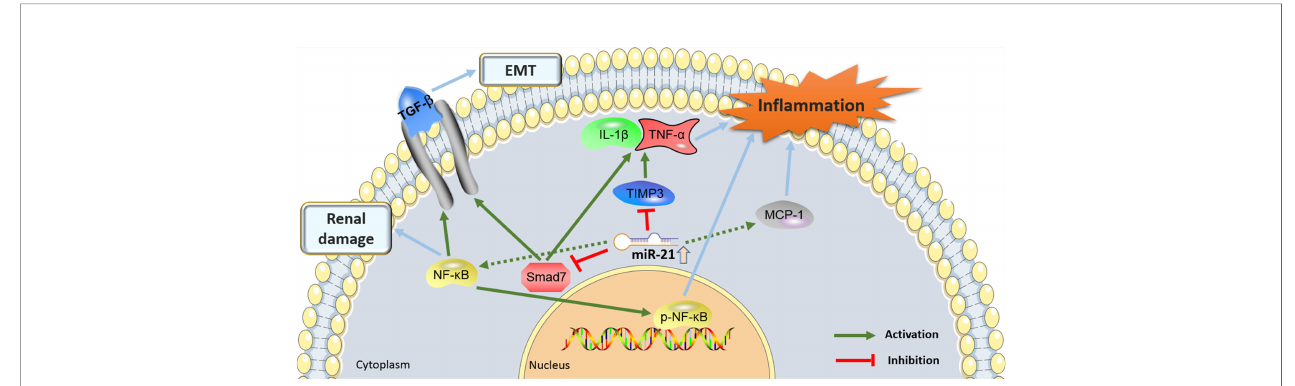
Figure 3. The proin fl ammatory molecular mechanisms by which the miR-21 and its target genes contributes to the pathogenesis of diabetic nephropathy (DN). miR- 21, MicroRNA-21; TGF- b , Transforming growth factor- b ; TIMP3, tissue inhibitors of metalloproteinase 3; EMT, epithelial-to-mesenchymal transition; NF-Kb, nuclear factor k B; MCP-1, monocyte chemoattractant protein